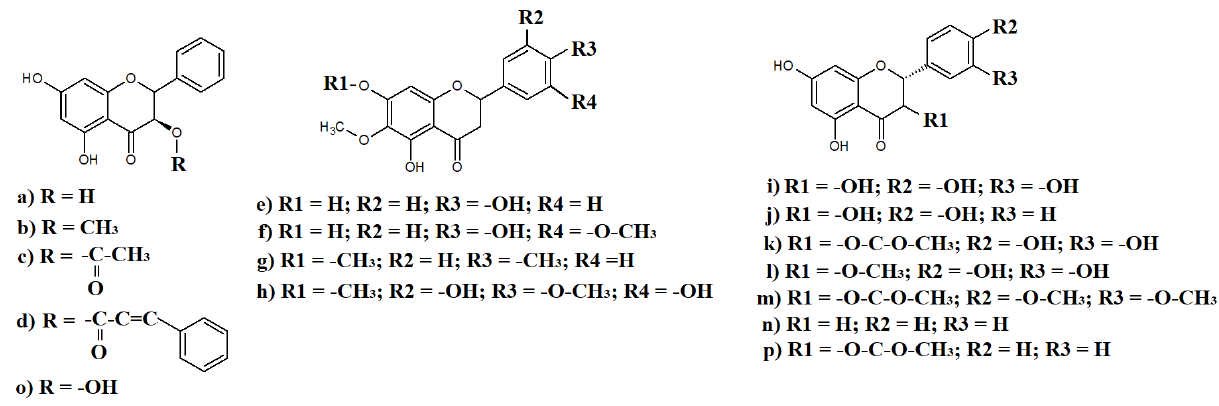
Figure 2. Some flavonoids detected in selected Eremophila spp.: ( a ) pinobanksin; ( b ) galangin-3-methyl ether; ( c ) pinobanksin-3-acetate; ( d ) pinobanksin-3-cinnamate; ( e ) hispidulin; ( f ) jaceosidin; ( g ) cirsimaritin; ( h ) 3′,5,5′-trihydroxy3,4′,6,7-tetramethoxyflavone; ( i ) taxifolin; ( j ) dihydrokaempferol; ( k ) 3-O-acetyltaxifolin; ( l ) quercetin-3-methyl ester; ( m ) 3-acetoxyhespertin; ( n ) pinocembrin; ( o ) galangin; ( p ) pinobanksin-3-acetate; and ( q ) galangin-3-methyl ether.